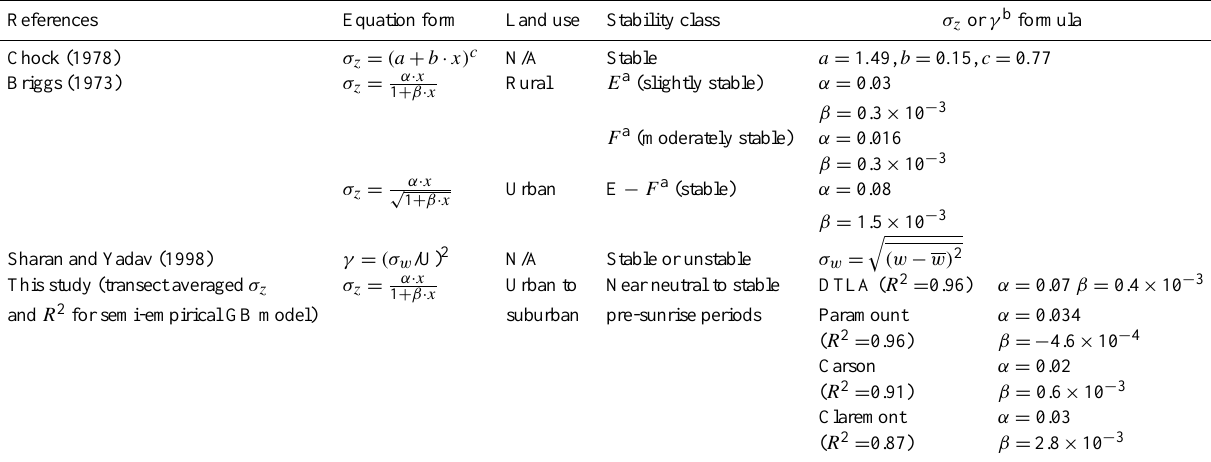
Table 1. Parameterizations of σ z for Gaussian and K-theory dispersion models and σ z values obtained from transect-averaged ultrafine particle concentration profiles in this